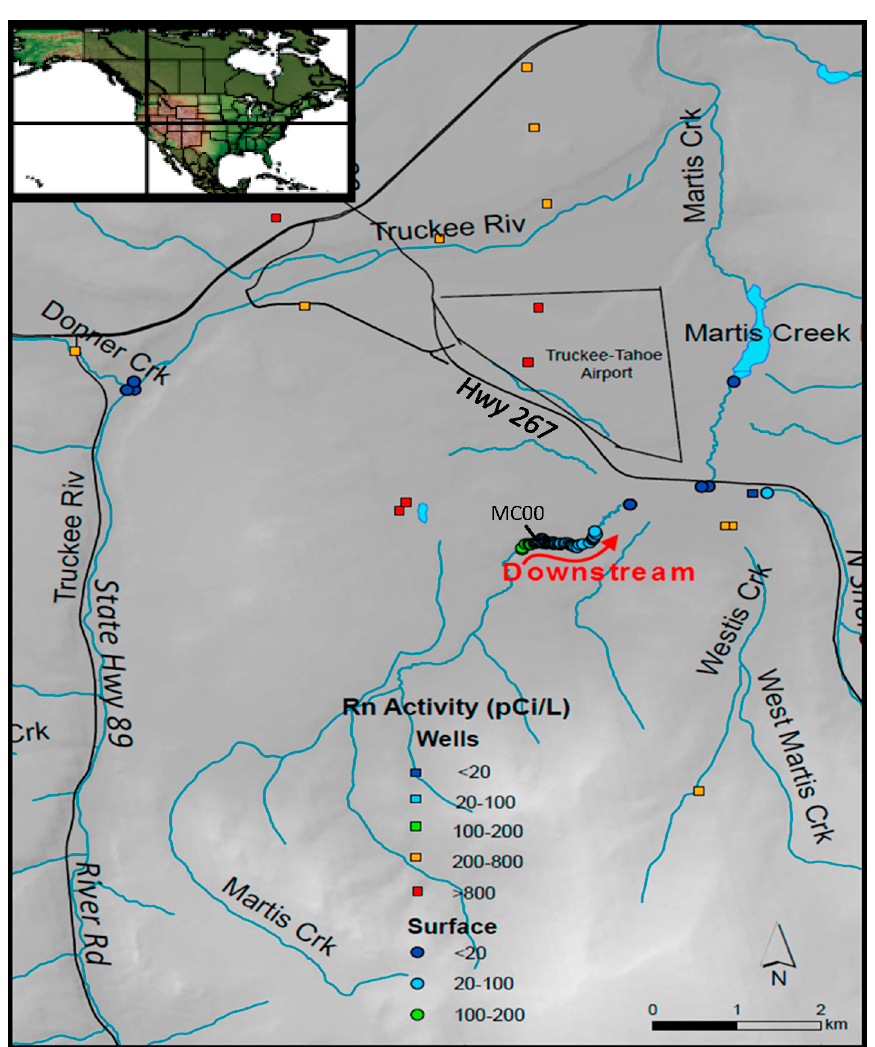
Figure 1. Location map showing results of a distributed survey of 222 Rn in wells and streams. The closely spaced samples are the focus of the tracer experiment, where tracer was introduced at location MC00 and where groundwater influx to Martis Creek is quantified.